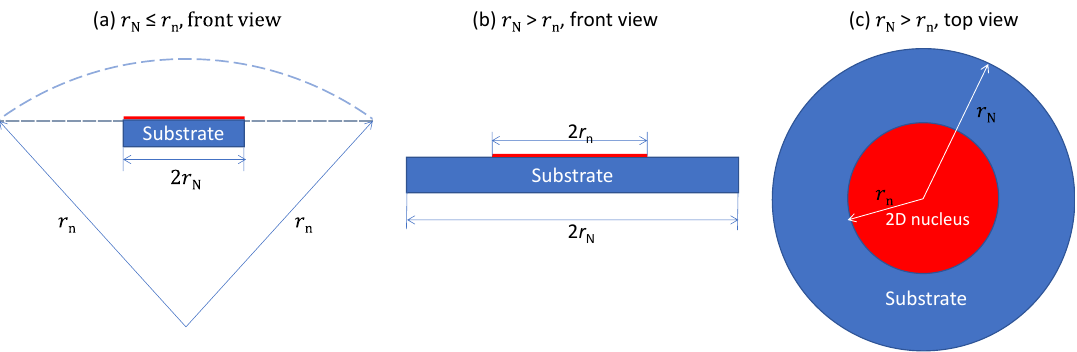
Figure 4. Schematic illustration of substrate size effect on heterogeneous nucleation behaviour. ( a ) when r N ≤ r n the 2D nucleus covers the entire substrate surface; and ( b ) when r N > r n the 2D nucleus only covers partially the substrate surface, as shown in ( c ).